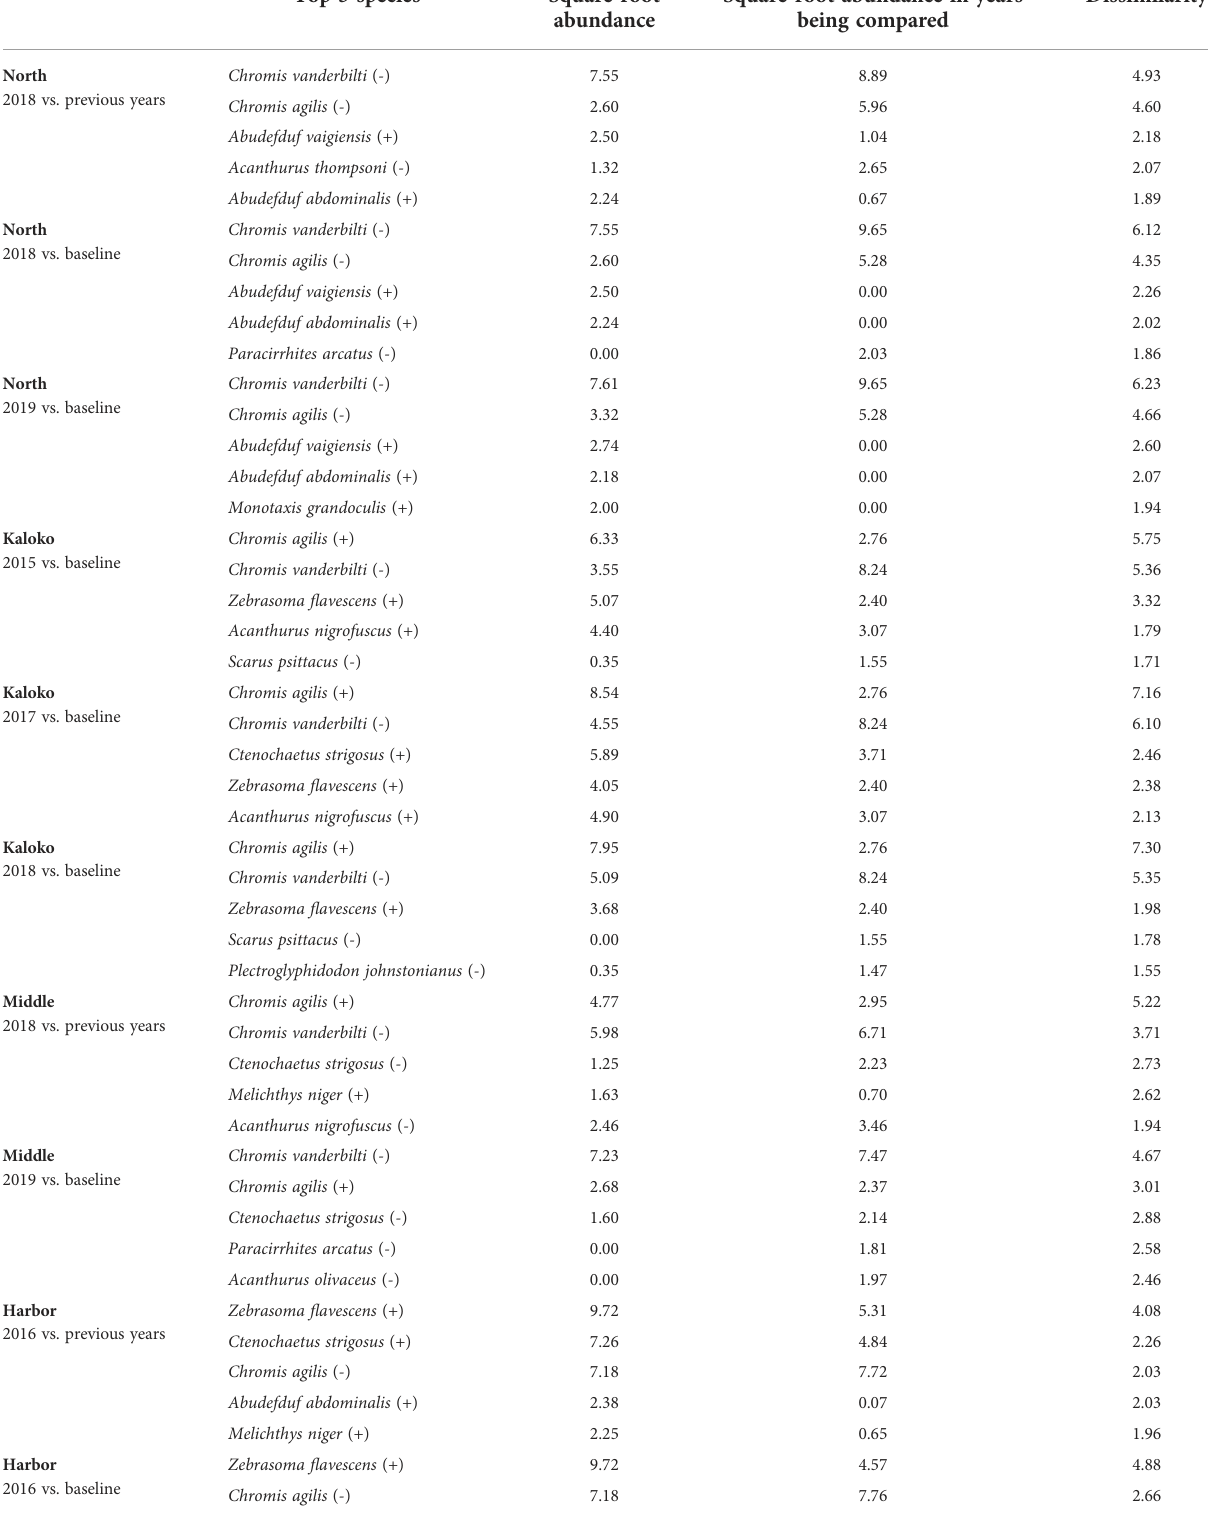
Top 5 species Square-root Square-root abundance in years Dissimilarity abundance being compared